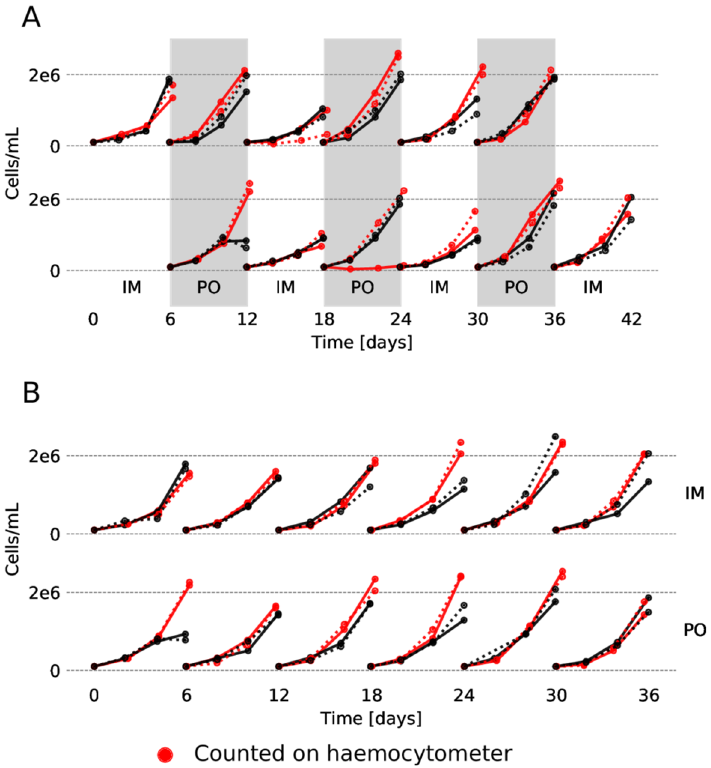
Figure 2. The number of cells (population size) over time for each culture. The timelines are grouped by the treatment. Replicates that were counted manually using a haemocytomer are indicated by red colour. ( A ) Cells exposed to drug rotations, aligned in time such that drug exposure coincides. ( B ) Cells exposed to monodrug therapy (washed every six days but not subject to rotation). The colours and line–styles are consistent between this figure and Fig.